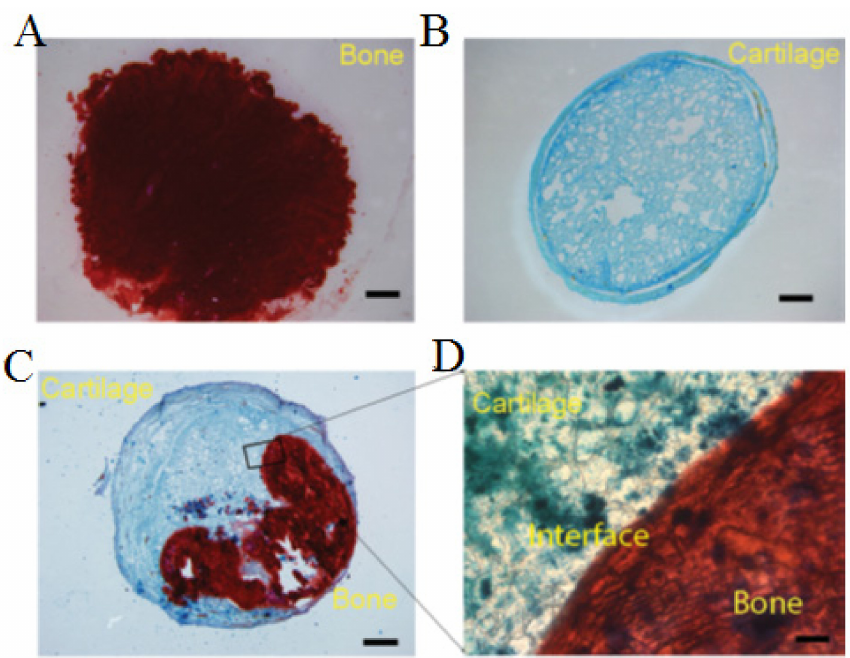
Figure 5. Formation self-healing hydrogel of Dextran-Ureidopyrimidinone (Dex-Upy) polymer. The bone–cartilage interface to the formation of osteochondral constructs in vivo. ( A ) Only group completely positive for Alizarin red staining to detect bone mineralization. ( B ) Sectioning cartilage alone completely positive for Alcian blue staining to detect cartilage tissue. ( C ) The bone–cartilage interface to the formation of osteochondral constructs in vivo. ( D ) Magnify the bone–cartilage interface. Reused with permission from [39] Copyright © 2021 Advanced Healthcare